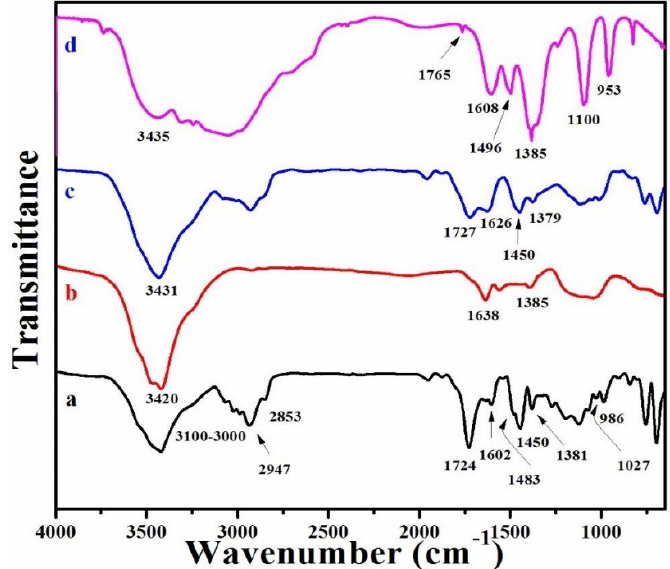
Figure 1. FT-IR spectra of ( a ) polystyrene (PS)-polymethylmethacrylate (PMMA), ( b ) reduced graphene oxide (RGO)/silver nanoparticles (AgNPs), ( c ) RGO/AgNPs-(PS-PMMA), and ( d ) R-(GO-(PS-PMMA)-AgNPs.